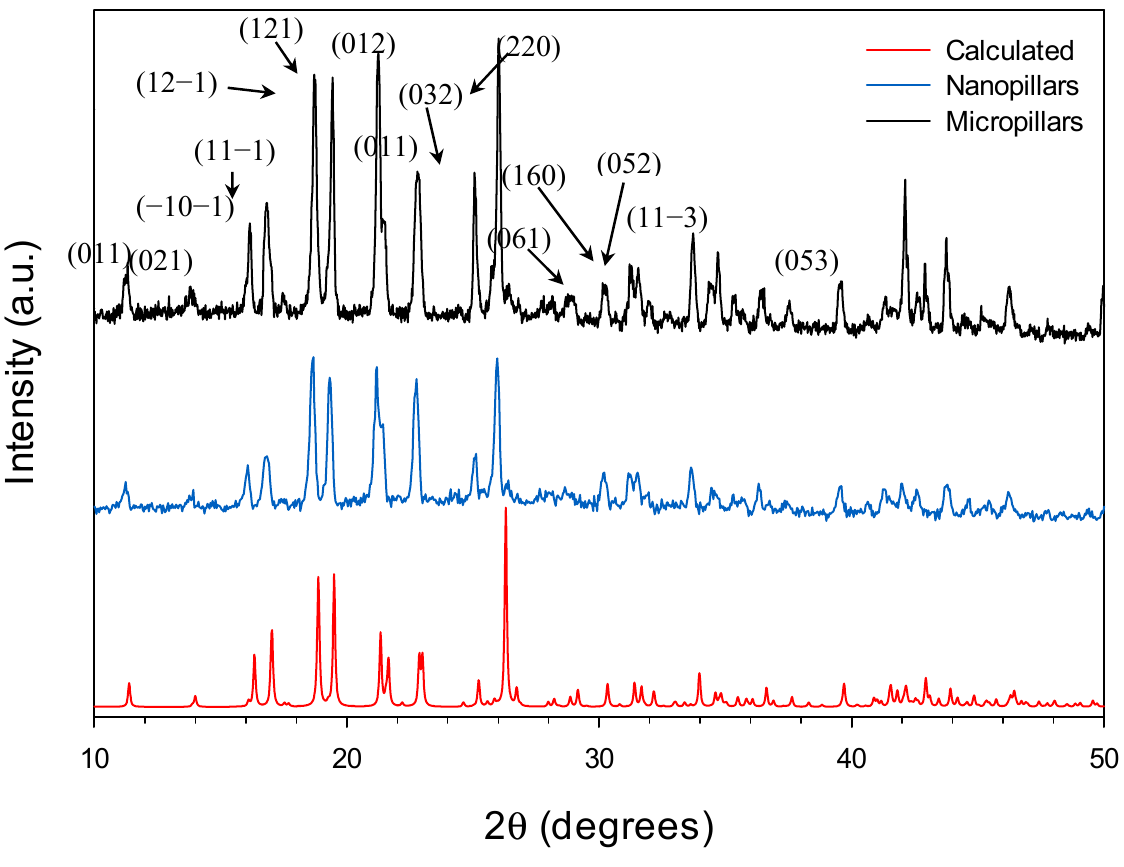
Figure 4. XRD diffraction patterns of Cu(BTC)·3H 2 O micropillars and